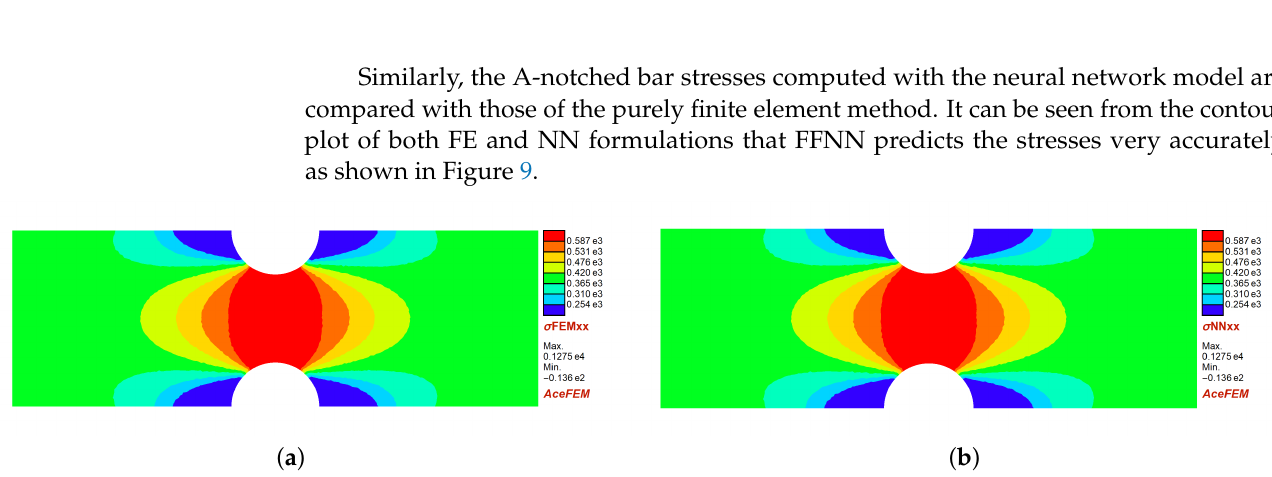
Figure 9. A-notched bar in tension. Contour plot of the stresses σ xx [N/mm 2 ] with ( a ) finite element method and ( b ) neural network formulation.